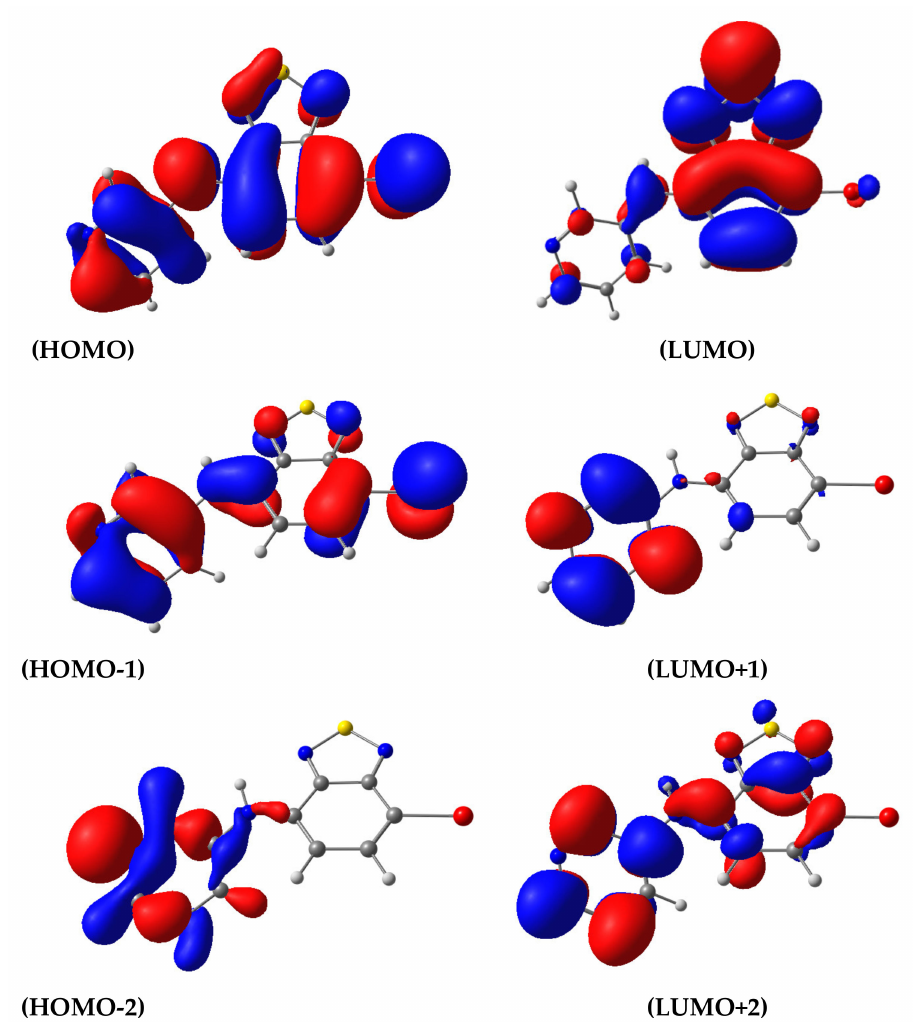
Figure 6. Frontier orbitals of 1 based on ZORA-PBE0/def2-TZVP(-f) calculation (isovalue = 0.02 a.u.). Upon UV- or blue light irradiation, the compounds emit light in the visible